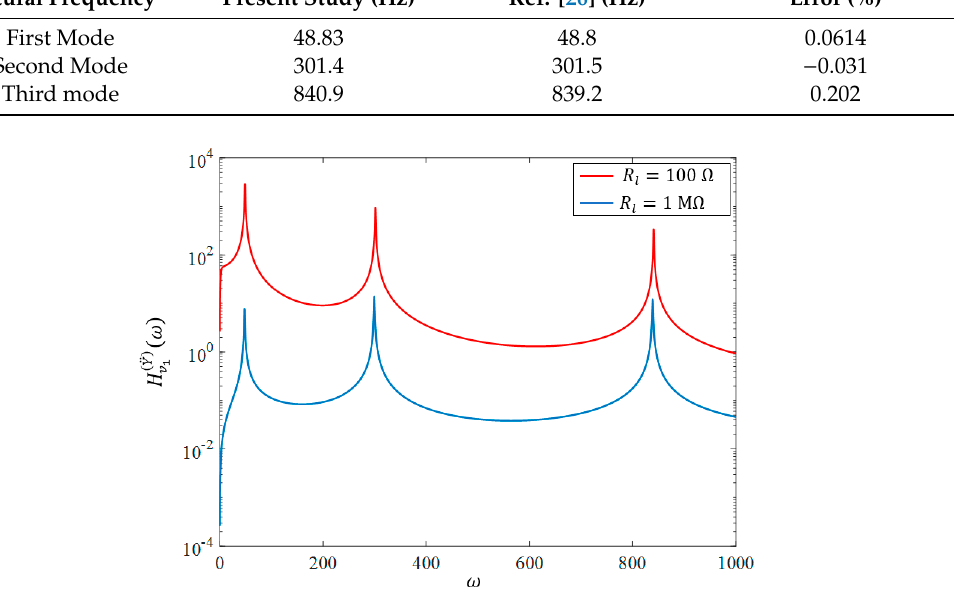
Figure 5. Frequency response curve of v 1 , of the sample system, due to harmonic base Figure 5. Frequency response curve of (cid:1874) (cid:2869) , of the sample system, due to harmonic base acceleration. Table 6. Comparison between the natural frequencies when (cid:1844) (cid:3039) = 100Ω .